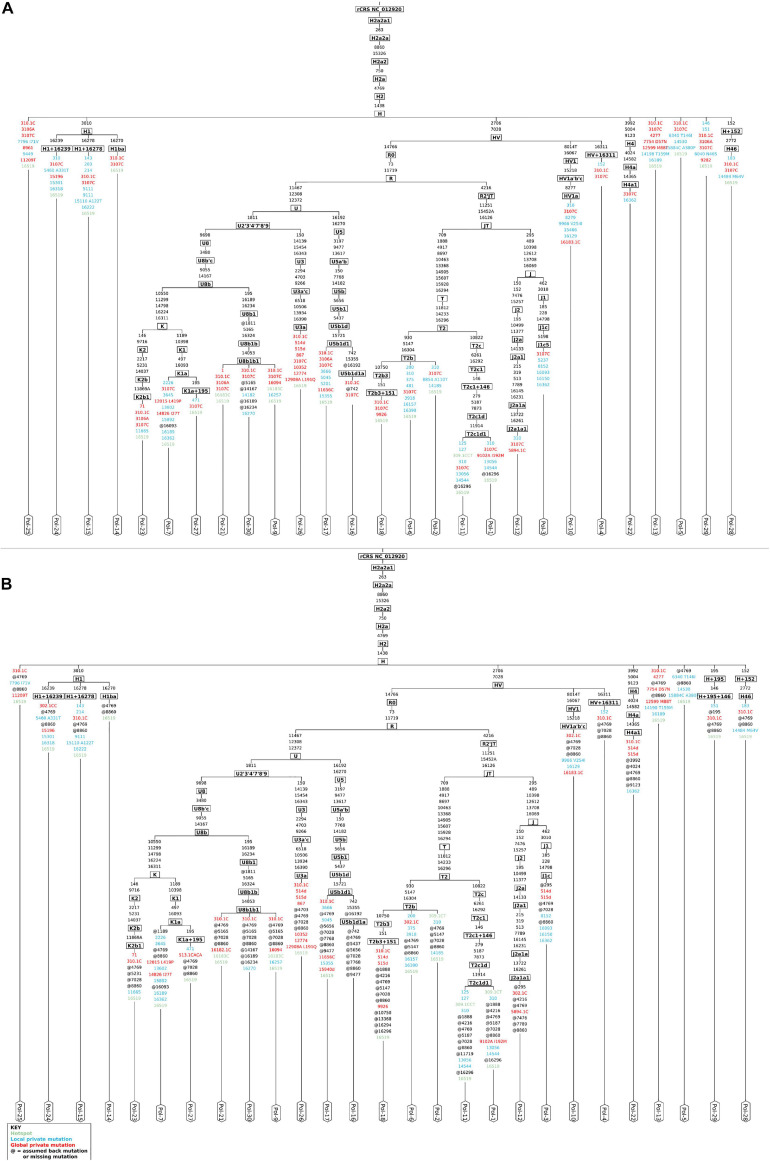
Mitochondrial phylogenetic trees from Polizzello sequences. Phylogenetic trees of mitochondrial DNA variation in Polizzello samples were obtained by Haplogrep2 from consensus sequences generated by schmutzi (A) and those obtained from variants called by Mutect2 and retained after filtering based on allele depth (≥10) and allele fraction (≥50%) and considering the highest contamination rate (2%) (B). Slightly different haplogroups were predicted for three samples (Pol-3, Pol-10, Pol-29). Amino acid changes are shown for non-synonymous variants.